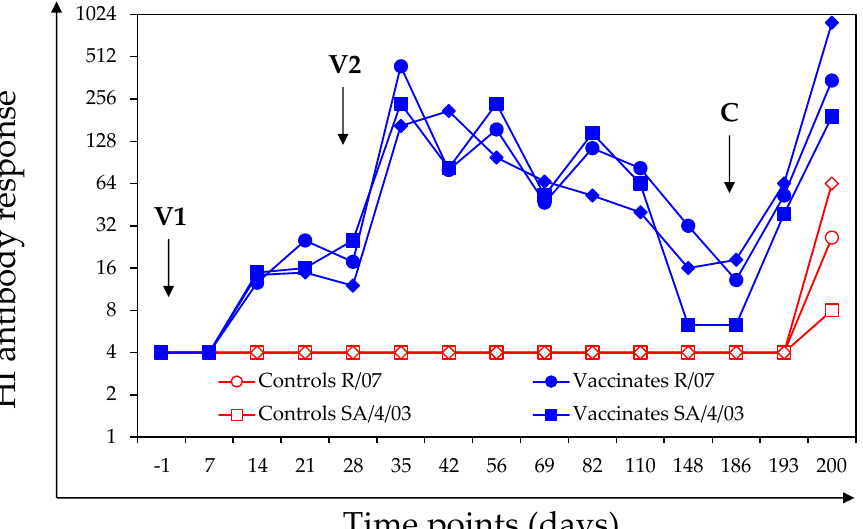
Figure 2. Group haemagglutination inhibition (HI) antibody response against A/equine/South Africa/4/03 (SA/4/03), A/equine/Richmond/1/07 (R/07) and A/equine/Northamptonshire/1/13 (N/1/13). Vaccination and infection are indicated with arrows. Closed symbols = vaccinated ponies; open symbols = control ponies. HI titres < 8 were converted into 4, for graphical reasons.